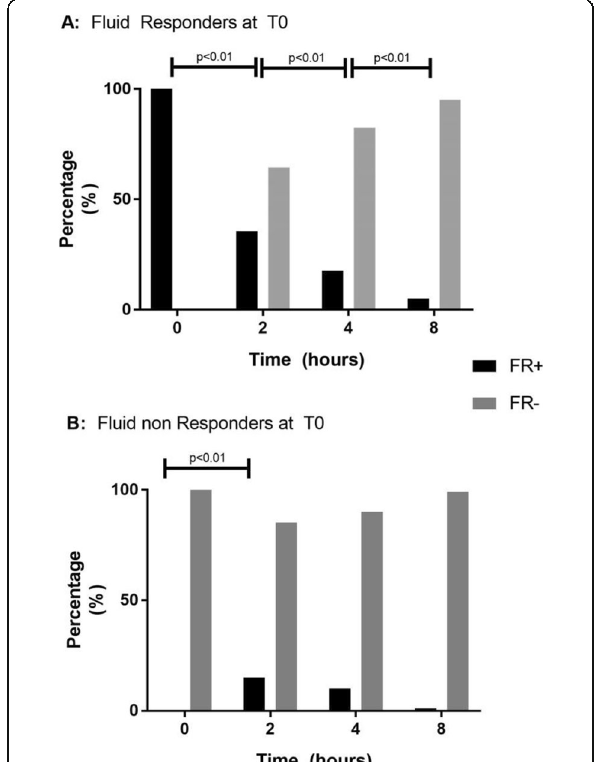
Fig. 1 (abstract 000858). See text for description